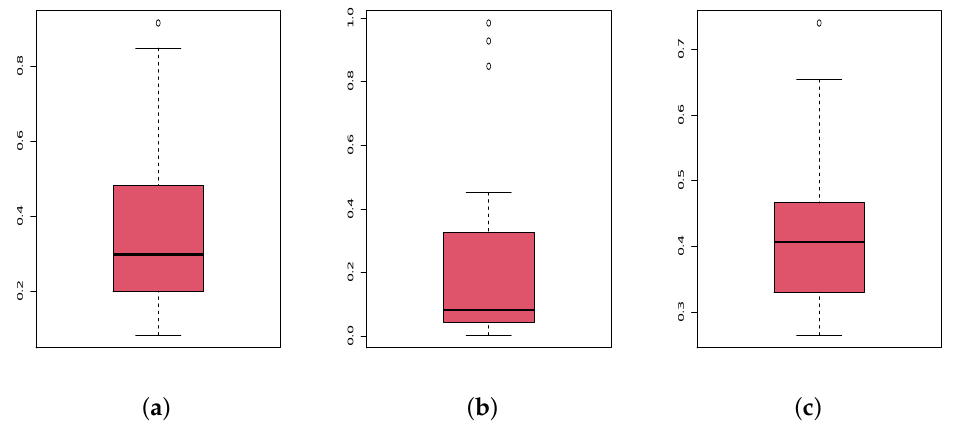
Figure 4. Boxplots of the ( a ) times of infection data set, ( b ) failure times data set and ( c ) flood levels data